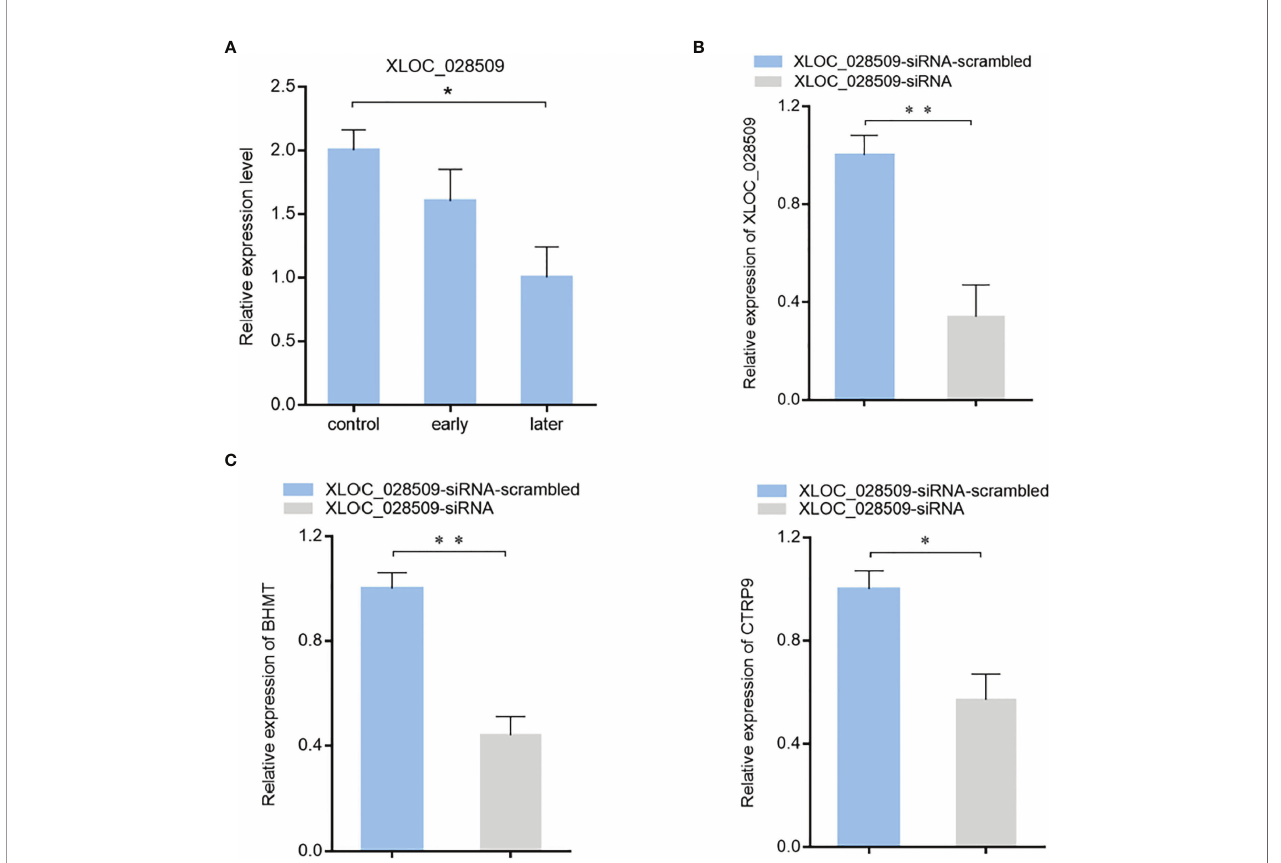
FIGURE 6 | The effects of lncRNA XLOC_028509 on target gene expression. (A) Expression level of lncRNA XLOC_028509 after Vibrio splendidus infection of sea cucumbers detected using quantitative real-time PCR. The error bars denote the means ± SD of three independent experiments (* p < 0.05). b -actin was used as a control. (B) Knockdown of XLOC_028509 by sequence-speci fi c siRNA. Sea cucumbers were injected with XLOC_028509-siRNA, as a control, XLOC_028509- siRNA-scrambled was included in the injection. At 36 h after injection, the expression level of XLOC_028509 was examined by quantitative real-time PCR. b -actin was used as a control. Error bars indicate the means ± SD of three independent experiments (** p < 0.01). (C) In fl uence of lncRNA XLOC_028509 silencing on the target genes expression. Sea cucumbers were respectively injected with XLOC_028509-siRNA and XLOC_028509-siRNA-scrambled, at 36 h after injection, the mRNA levels of BHMT and CTRP9 were analyzed by quantitative real-time PCR (* p < 0.05; ** p <